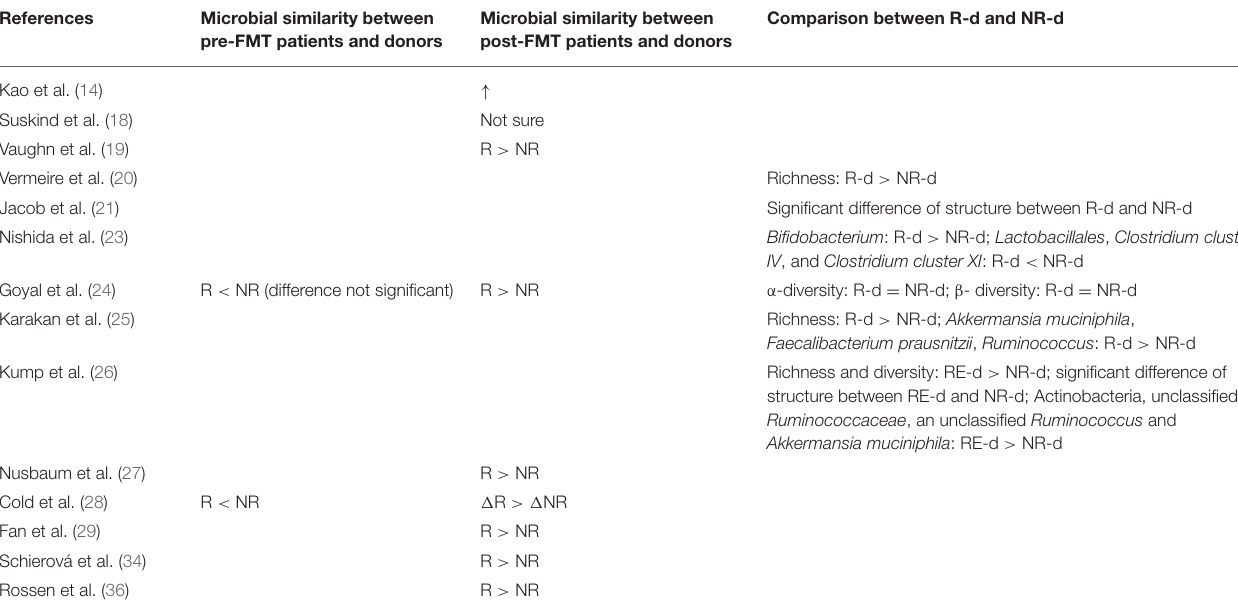
TABLE 2 | Association between donor microbiota and the response to FMT. Microbial similarity between Microbial similarity between pre-FMT patients and donors post-FMT patients and donors